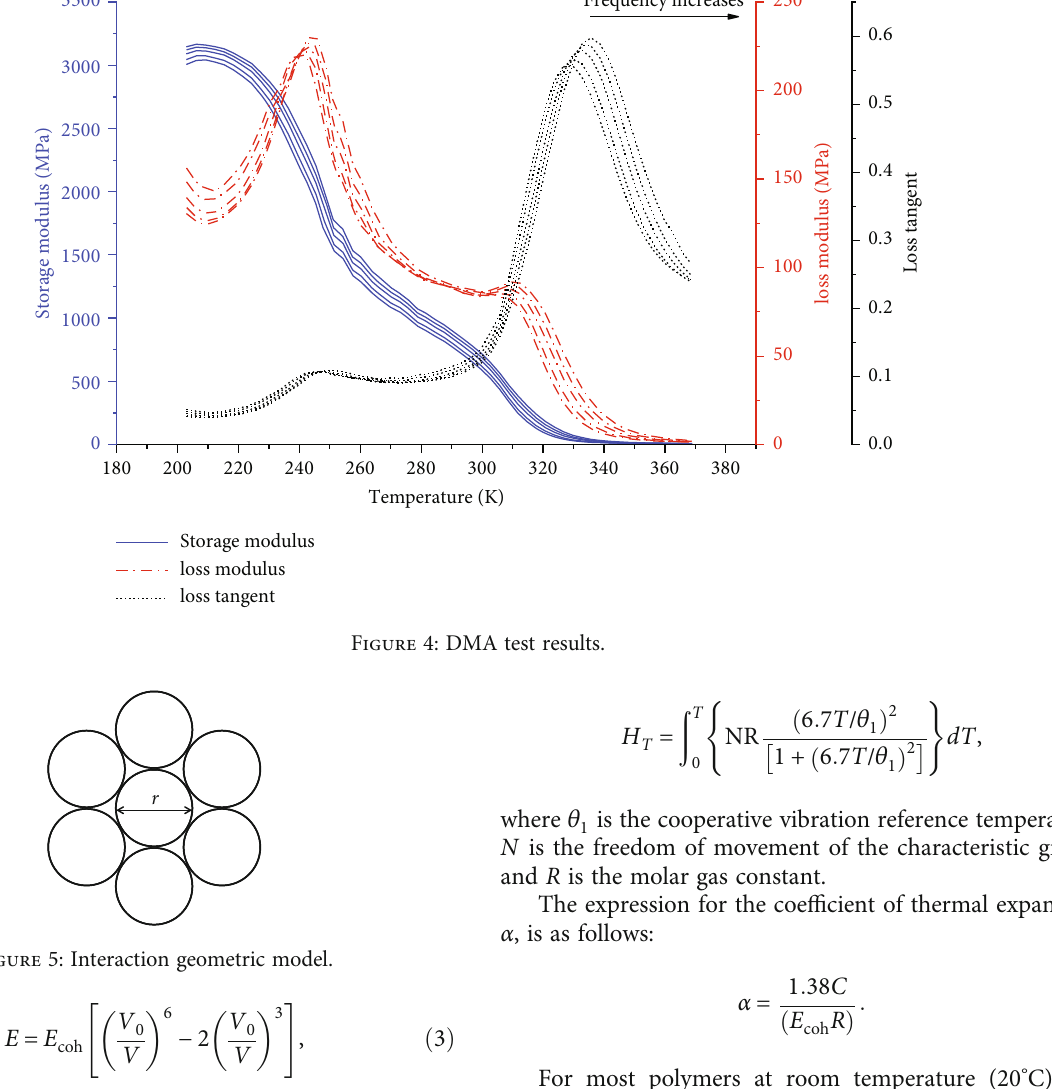
Figure 5: Interaction geometric